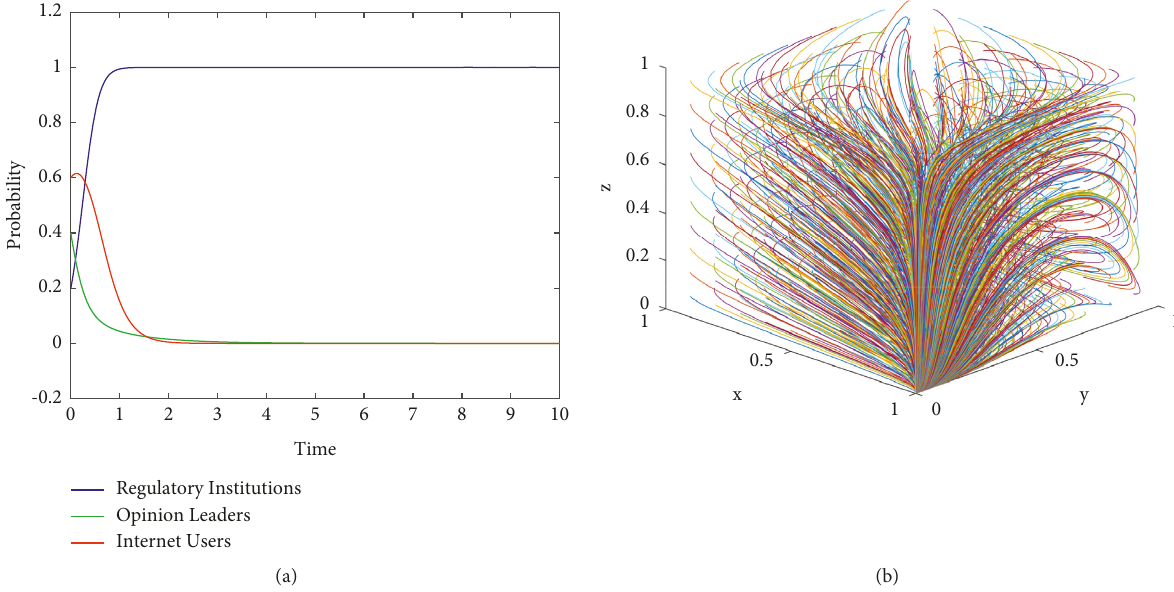
Figure 3: Tripartite evolutionary game trending figure stable at point E 5 (1,0,0) between “regulatory institutions, opinion leaders and Internet users.” (a) Strategy selection process. (b) 3D simulation diagram of the